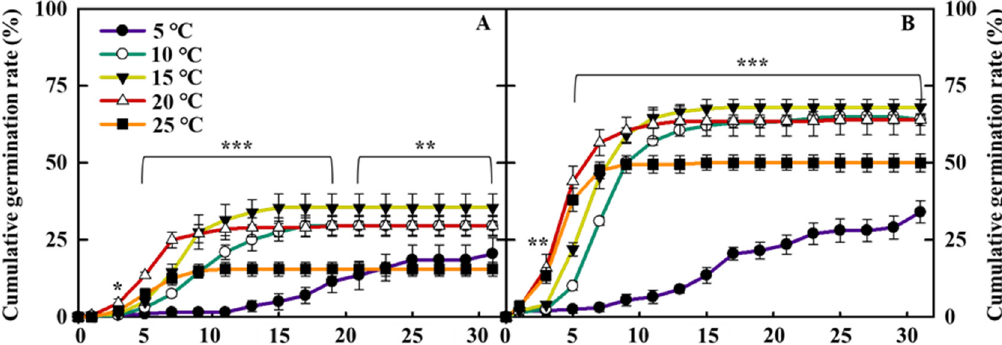
Figure 5. Cumulative germination rate of cold stratification treated coastal glehnia seeds with pericarps ( A ) and without pericarps ( B ) at five different air temperatures (5, 10, 15, 20, and 25 °C) for 31 days. The vertical bars indicate standard errors. *, **, and *** indicate significance at p < 0.05, 0.01, and 0.001, respectively ( n = 4).